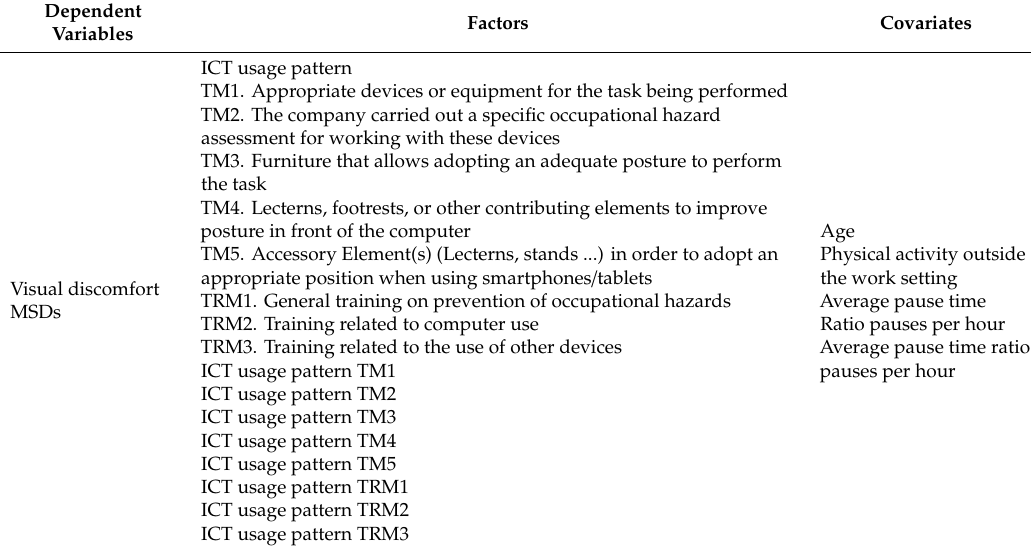
Table A2. Relationship between visual discomfort, MSDs, ICT usage patterns, and preventive measures. Initial model for